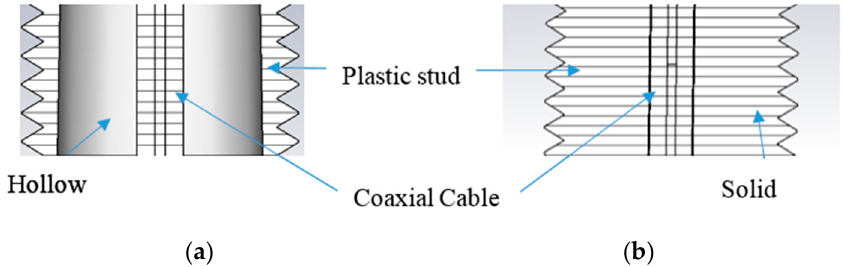
Figure 11. The plastic stud ( a ) with a hollow structure and ( b ) with solid ribs to hold the coaxial cable